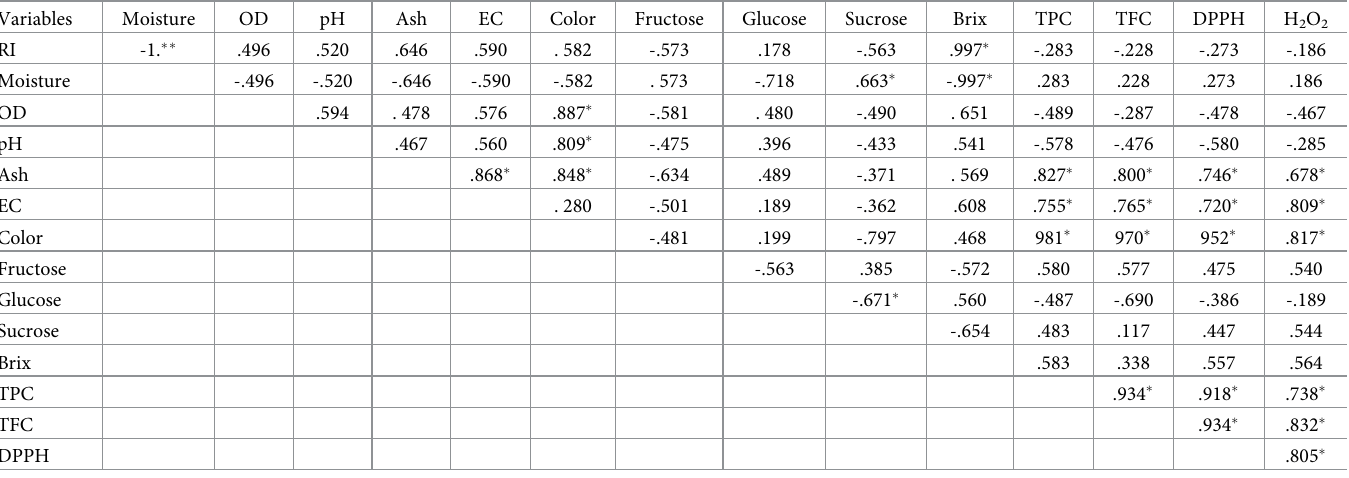
Table 4. Pearson correlation matrix among physicochemical and antioxidant properties of Schefflera abyssinica and polyfloral honey. Variables Moisture OD Moisture